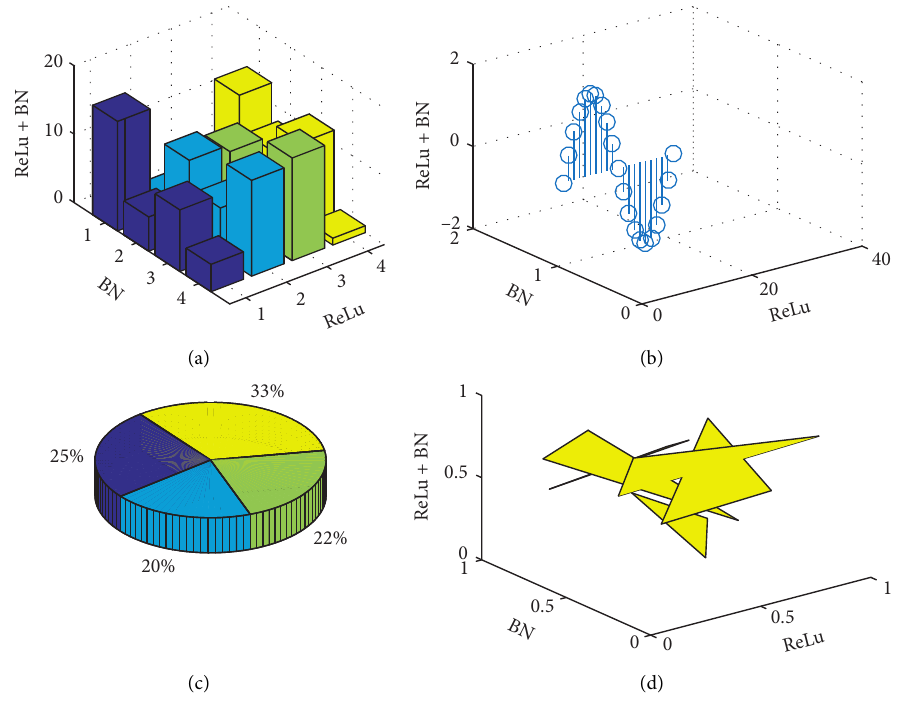
Figure 4: Comparison of activation function experiments.